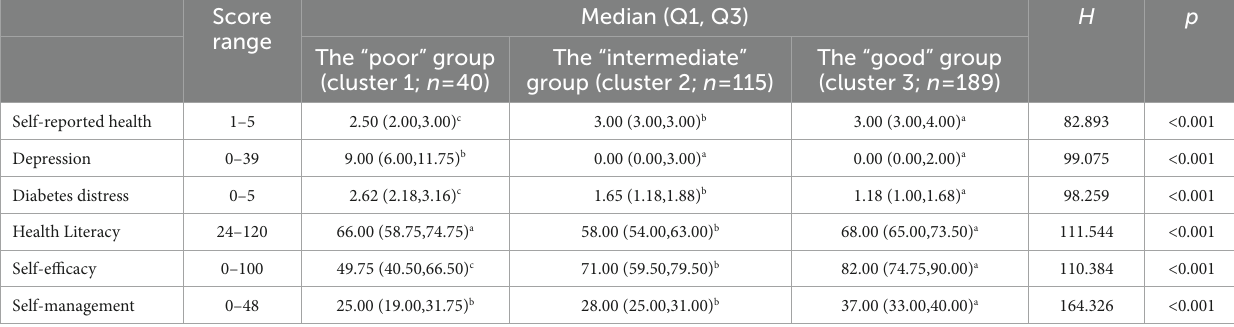
TABLE 3 Description of elderly, multimorbid patients with diabetes clusters according to self-reported data ( N = 344).